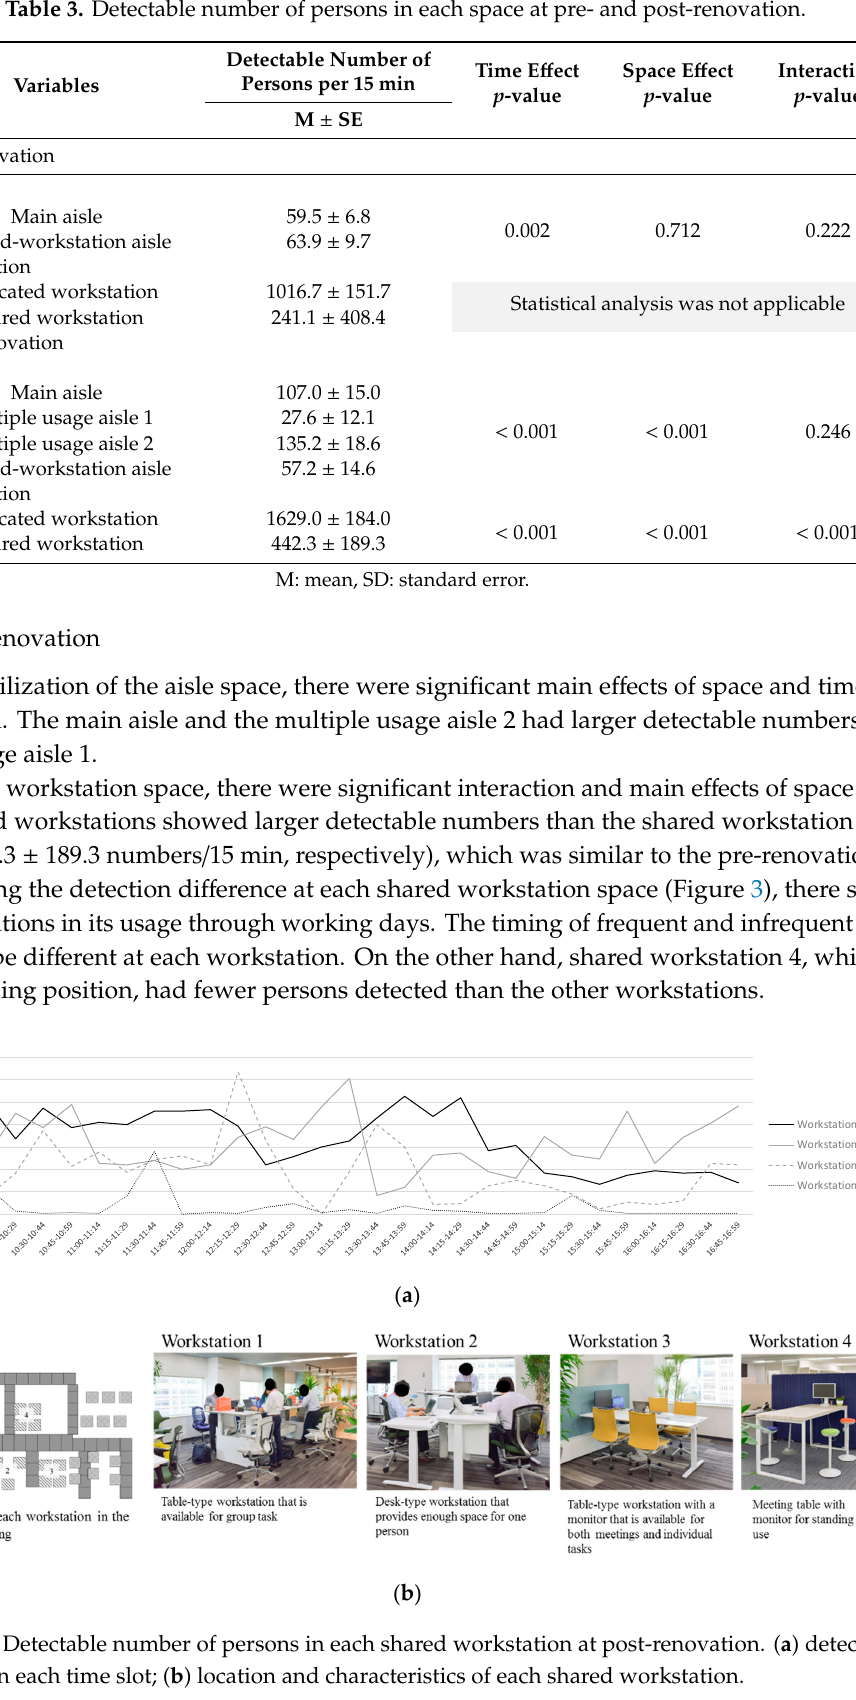
Table 3. Detectable number of persons in each space at pre- and post-renovation.